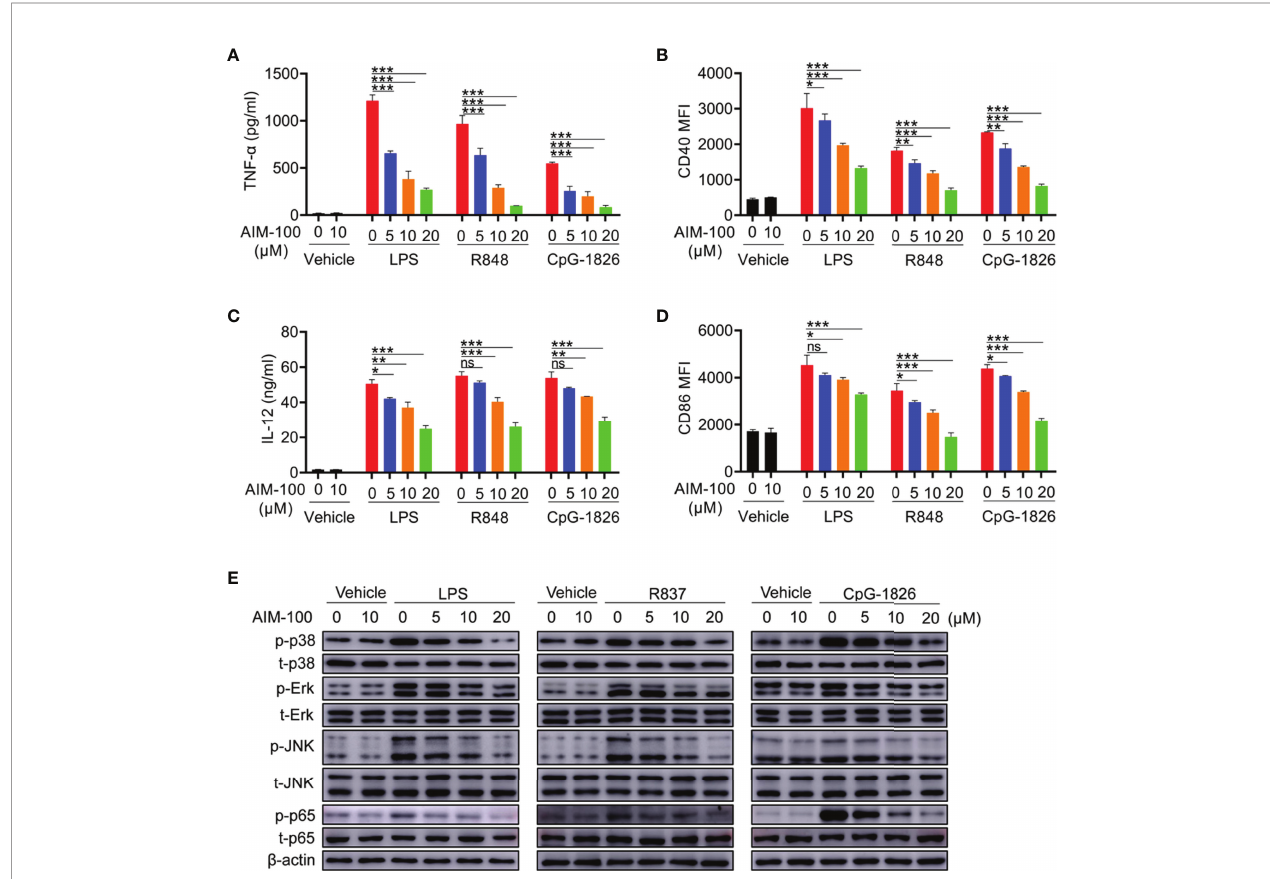
FIGURE 4 | ACK1 inhibitor weakens TLR-mediated activation of DCs. Bone marrow-derived BMDCs from C57BL/6 mice aged 6-8 weeks were pretreated with ACK1 inhibitor AIM-100 (5, 10 and 20 m M) for 2 hours, and were then stimulated with LPS (100 ng/mL), R848 (1 m g/mL) and CpG-1826 (1 m M). FACS analysis of the expressions of CD86 (A) and CD40 (B) on BMDCs at 24 hours. The levels of IL-12 (C) and TNF- a (D) secreted by BMDCs were detected by ELISA at 24 hours. Western blot analysis of the phosphorylation levels of p38, Erk, JNK and p65 at 1 hour (E) . The data shown represent the means of three independent experiments and the error bars represent the S.E.M. * p <0.05, ** p <0.01, and *** p <0.001, as were determined by ANOVA tests; ns denotes p >0.05. b -actin was used as loading